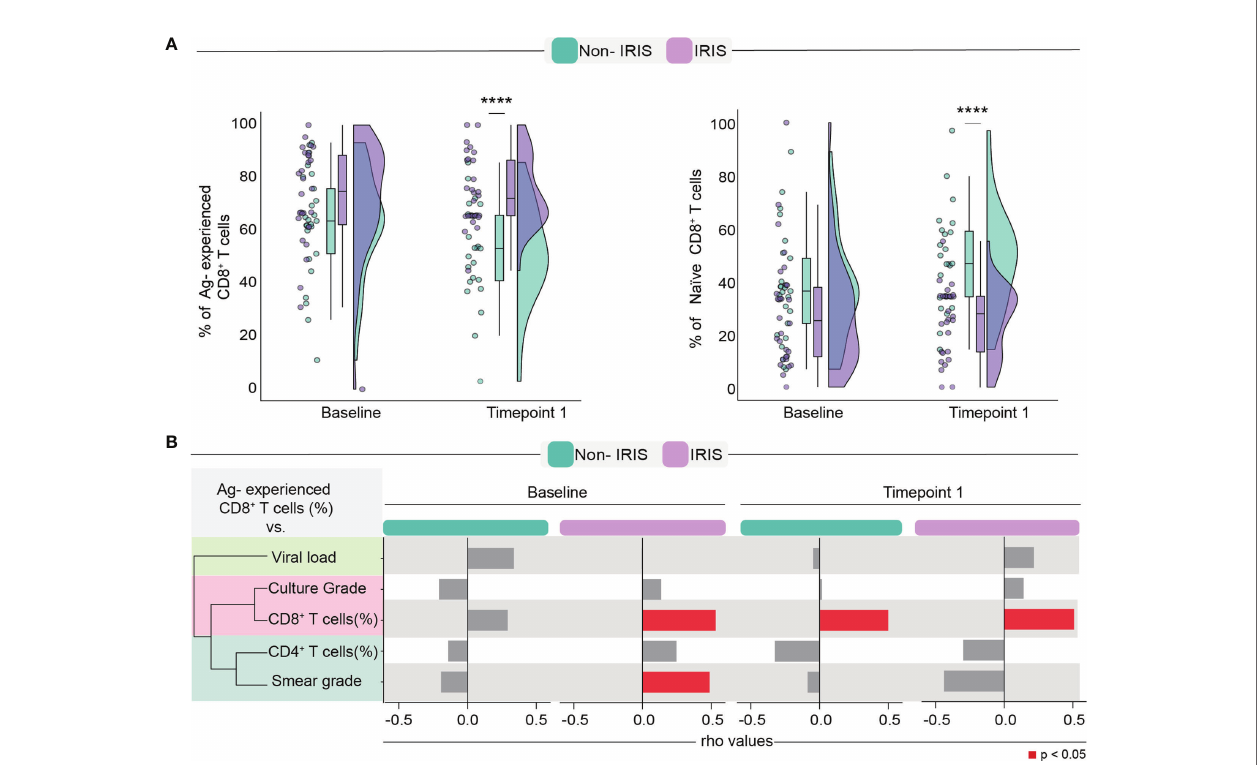
FIGURE 1 | Assessment of Antigen-experienced CD8 + T cells before and after ART commencement. (A) Comparison of frequencies of Antigen-experienced and naïve CD8 T cells. (B) Spearman correlation analysis between Antigen-experienced CD8 + T cell frequencies and surrogate clinical parameters at both timepoints. Data were analyzed using the Mann-Whitney test or Wilcoxon matched-pairs test for paired analyses within each study group (****p <